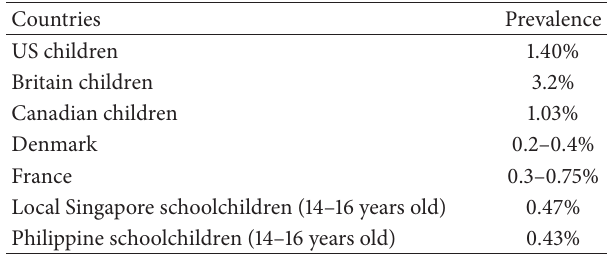
Table 1: The prevalence of peanut allergy in some countries [3–8].